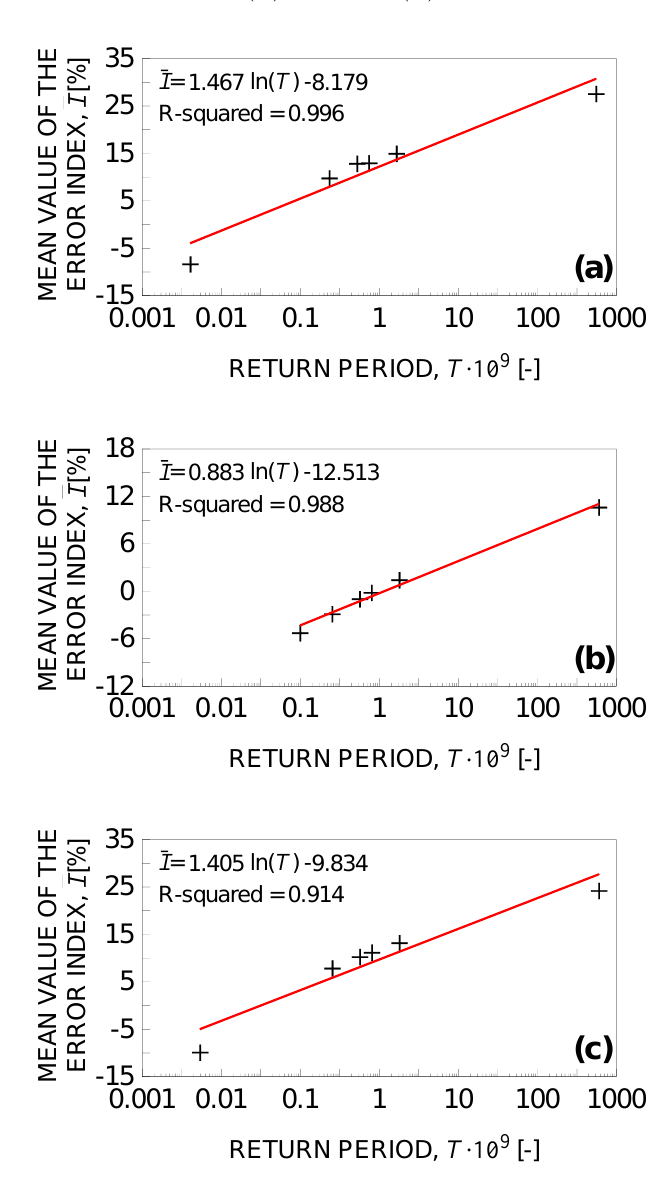
Figure 2. I T values vs. n values for: ( a ) EN-GJS-400-18 DCI; ( b ) EN-GJS-600-3 DCI; ( c ) EN-GJS- 700-2 DCI.